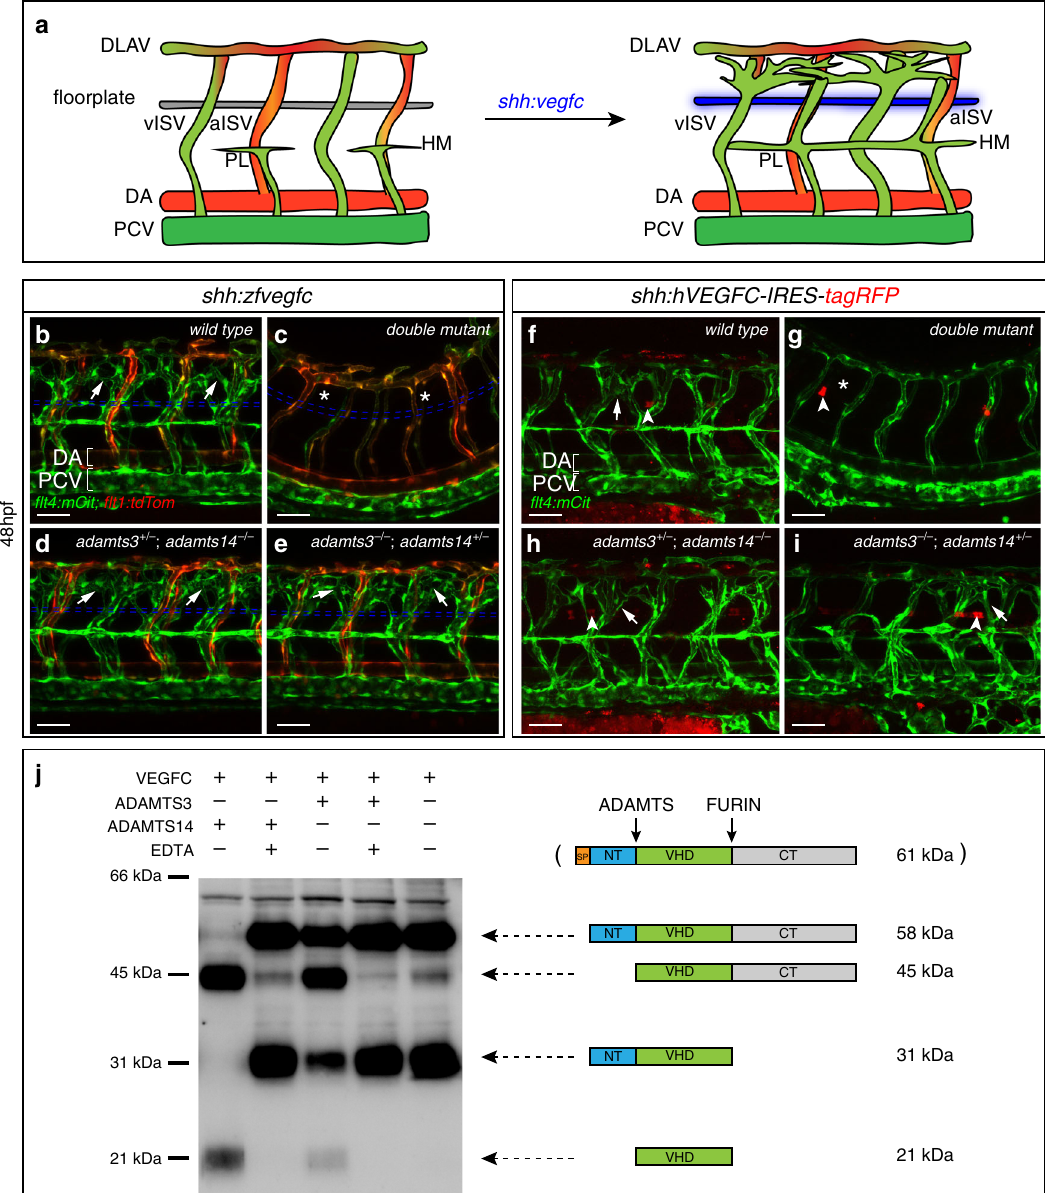
Fig. 2 Adamts3 and Adamts14 are both able to process pro-Vegfc. a Schematic depiction of the in vivo Vegfc-processing assay. In wild-type embryos, fl oorplate expression of full-length Vegfc results in venous hyper-branching at 48 hpf. b – e fl t4:mCitrine; fl t1:tdTomato transgenic embryos with arterial structures in red and venous and lymphatic structures in green. b , c While forced expression of full-length zebra fi sh Vegfc from the fl oorplate leads to hyper-branching in wild-type embryos ( b , arrows), this dominant phenotype is not visible in adamts3 ; adamts14 double mutants ( c , asterisks). Allelic combinations with one remaining wild-type copy of either adamts3 ( d ) or adamts14 ( e ) develop the Vegfc-induced hyper-branching phenotype. Blue lines indicate the fl oorplate position ( n = 225 analyzed embryos). f – i Mosaic expression of full-length human VEGFC in fl oorplate cells (marked by tagRFP expression) results in local venous hyper-branching in wild-type embryos ( f ), but not in adamts3 ; adamts14 double mutants ( g ). One functional copy of either gene ( h , i ) is suf fi cient to restore the dominant phenotypes ( n = 157 injected tagRFP + embryos). Scale bars: 50 µ m. DA dorsal aorta, DLAV dorsal longitudinal anastomotic vessel, hpf hours post fertilization, HM horizontal myoseptum, a/vISV arterial/venous intersegmental vessel, PCV posterior cardinal vein, PL parachordal lymphangioblast. j N-terminal processing of human VEGFC by ADAMTS3 and ADAMTS14 proteases. Conditioned medium from HEK293 cells expressing full-length VEGFC was incubated with ADAMTS3, ADAMTS14, or control buffer, in the presence or absence of EDTA. VEGFC forms were analyzed by Western blotting. In absence of active ADAMTS proteins (lanes 2, 4, and 5), VEGFC can be detected as a 58 kDa (full- length VEGFC without SP) and a 31 kDa form (C-terminally processed VEGFC without SP). In the presence of active ADAMTS14 (lane 1), the 58 kDa form is converted into a 45 kDa polypeptide while the 31 kDa form is processed into the fully mature 21 kDa VEGFC, which is in line with N-terminal processing of VEGFC proteins. A similar shift in VEGFC forms is detectable in the presence of active ADAMTS3 (lane 3) [source data are provided as a Source Data fi le]. Schematic depicting different VEGFC forms and their molecular weights. SP signal peptide, NT N-terminal propeptide, VHD VEGF homology domain, CT C-terminal